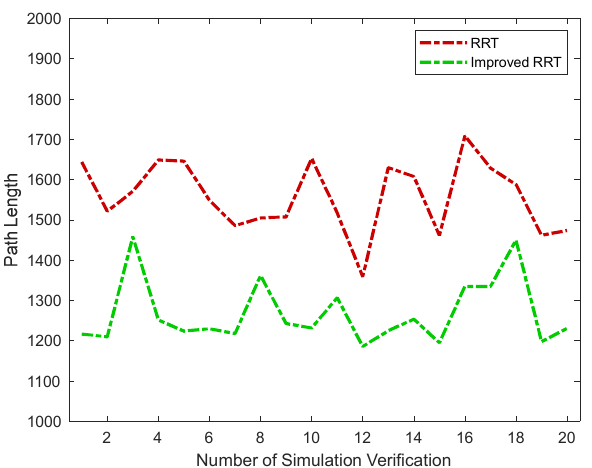
Figure 14. Comparison of the path lengths of the two algorithms.